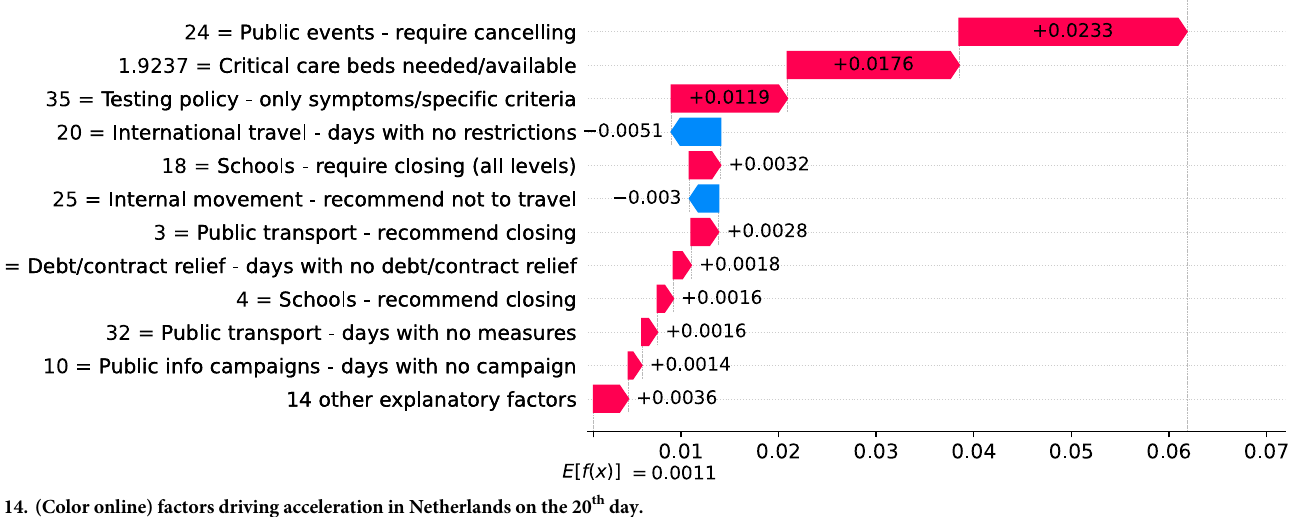
Fig 14. (Color online) factors driving acceleration in Netherlands on the 20 th day.